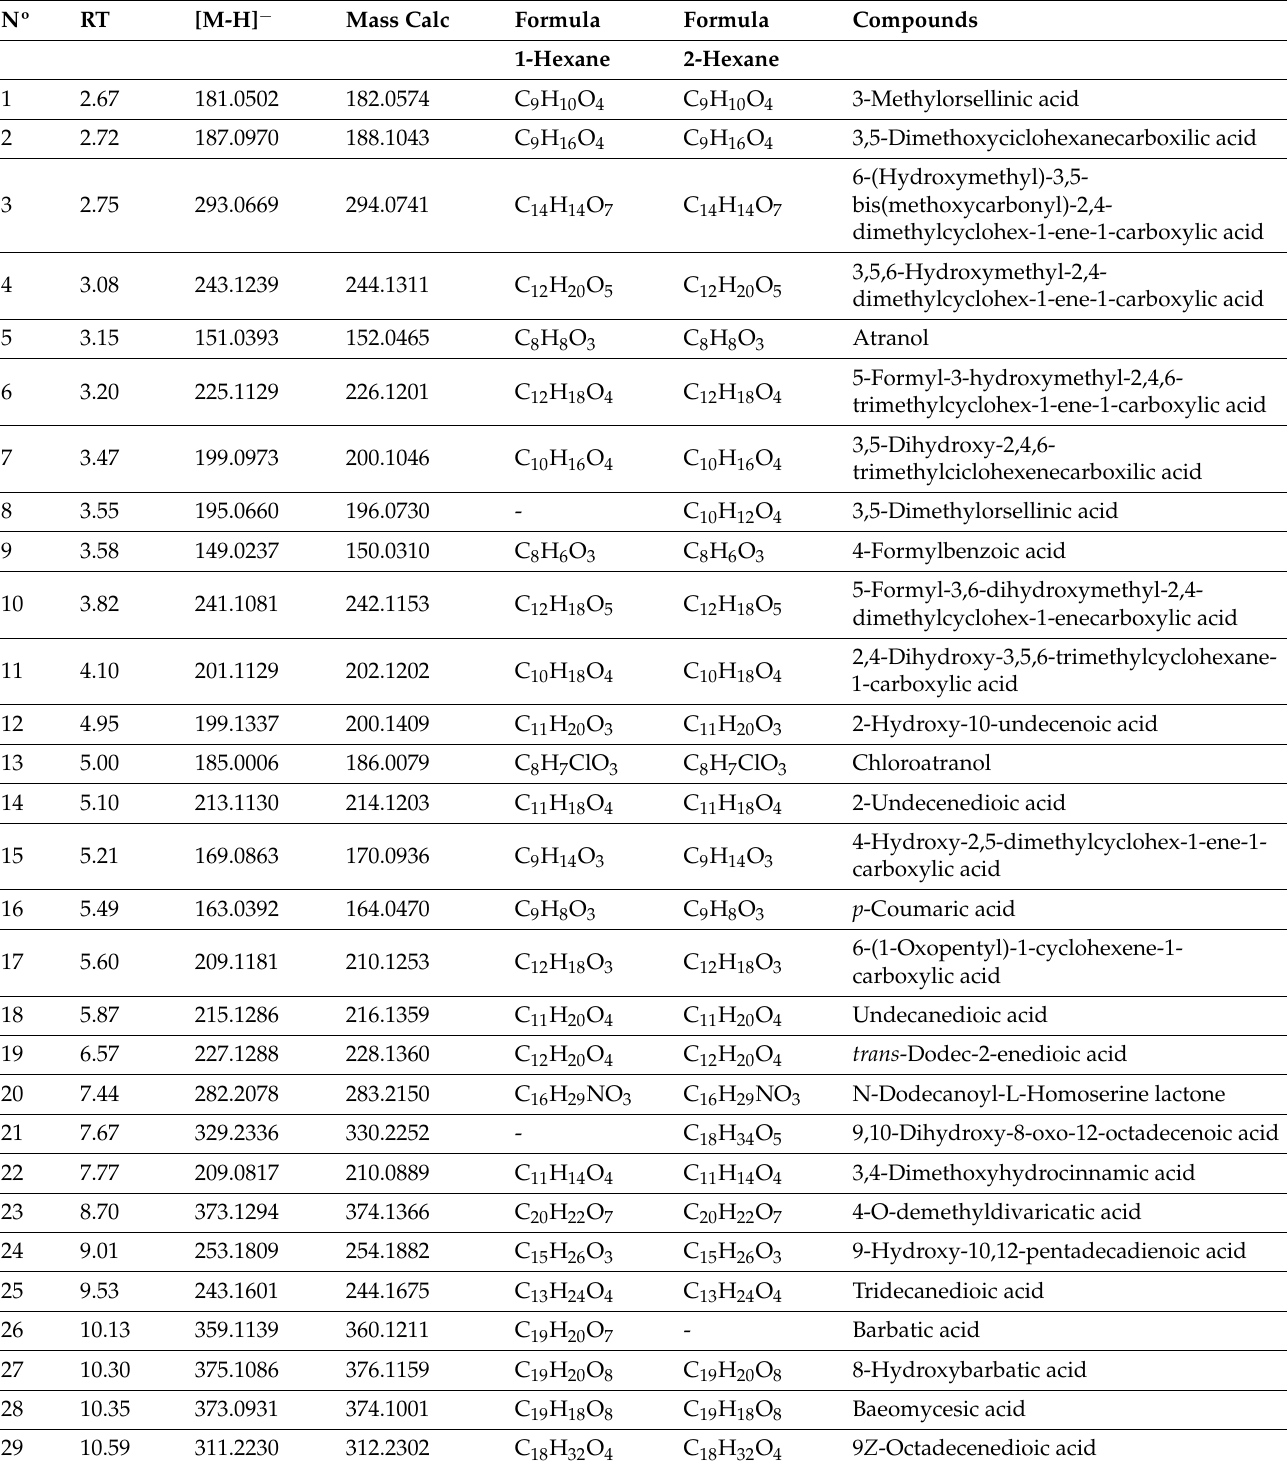
Table 5. Samples Parmotrema hypoleucinum (in Olea europea ), Hexane extract part soluble